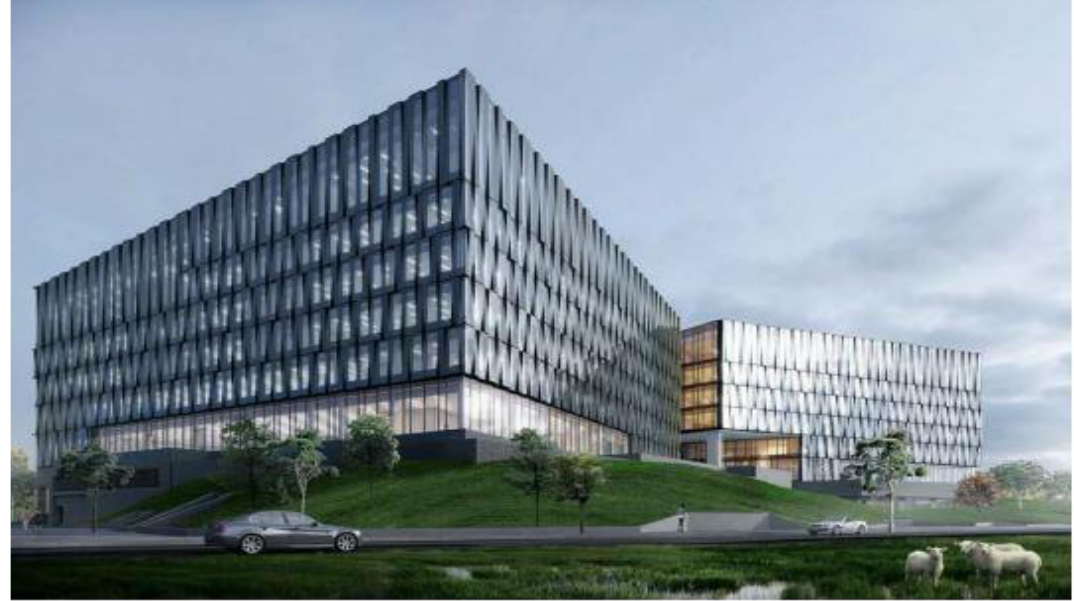
Figure 5. Nordea Bank Headquarters: south-west view. [Source: Henning Larsen